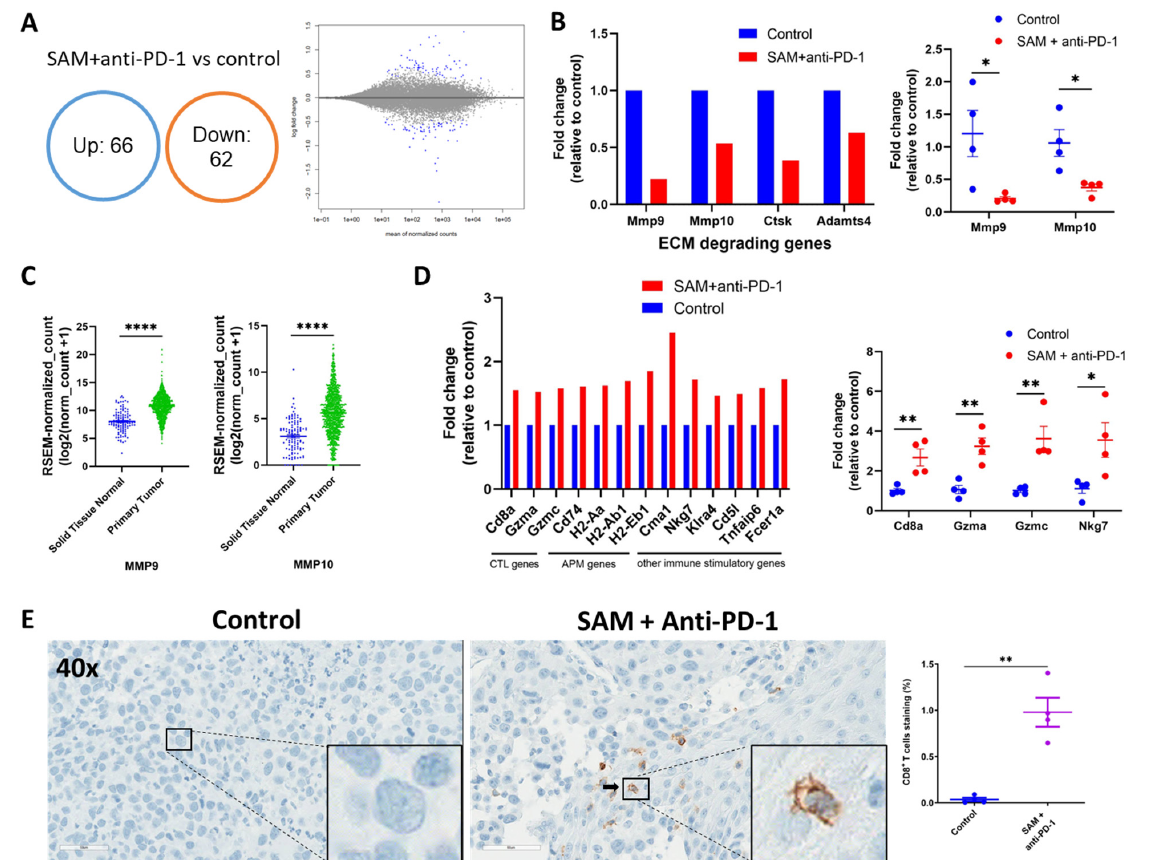
Figure 6. Tumors treated with the SAM and anti-PD-1 antibody combination show reduced expression of key oncogenes and pro-metastasis genes, and elevated expression of immunostimulatory genes. ( A ) Venn diagram (left) and MA plot (right) showing significant DEGs ( p < 0.001) in SAM and anti-PD-1 antibody combination-treated Eo771 tumors versus control Eo771 tumors. Up, upregulated genes; down, downregulated genes. ( B ) Change in expression of significantly downregulated genes in the combination-treated versus control tumors extracted from RNA-seq data (left, n = 3/group) and validated with RT-qPCR (right, n = 4/group). The data are presented as fold change in expression in the treatment group relative to the control. The value of the control was set at 1. ( C ) Expression of key pro-metastatic genes MMP9 and MMP10 in human solid normal tissue and primary tumor tissue of breast cancer patients derived from GTEx and TCGA databases ( n = 1391 samples) using the Xena platform. Expression values are depicted in RSEM, which is RNA-Seq by Expectation Maximization. ( D ) Change in expression of top significantly upregulated genes in combination-treated versus control tumors extracted from RNA-seq data (left, n = 3/group) and validated with RT-qPCR (right, n = 4/group). Data is presented as fold change in the treatment group relative to the control. The value of the control was set at 1. CTL, cytotoxic T lymphocytes; APM, antigen processing and presentation machinery. ( E ) Immunohistochemistry with CD8a + T cell marker staining of Eo771 tumors treated with the combination treatment and the controls. ( E , left) Representative images (lens, 40×; magnification, 400×) of the primary Eo771 tumors stained with murine antibody against CD8a + marker (brown) from the control and SAM+anti-PD-1 antibody combination-treated tumors. The nuclei are stained blue and a CD8 + T cell is indicated by a black arrow. Enlarged images at the bottom right show the absence and presence of CD8 + T cells in the control and SAM+anti-PD-1 antibody group, respectively. ( E , right) CD8a + T cell positive staining area percentage ( n = 4 samples/group). Statistical significance was determined using ( C , E ) T-test in GraphPad prism and ( A , B , D ) by Wald test with BH FDR ( ≤ 0.2 ) correction. Significance values are represented by asterisks ( * p < 0.05; ** p < 0.01; **** p < 0.0001).